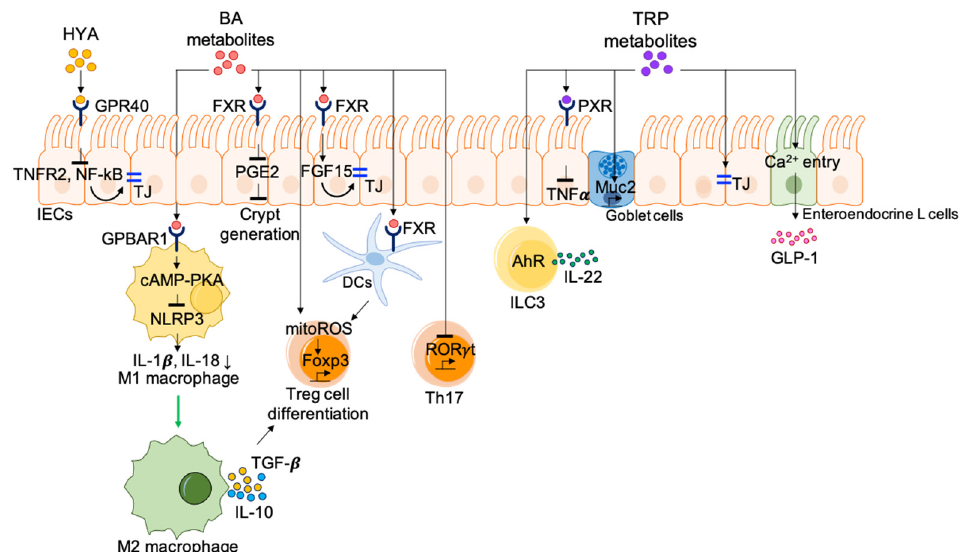
Figure 3. Immune regulation by metabolites derived from lipids and amino acids. Microbial metabolites produced from lipids and amino acids regulate intestinal homeostasis. HYAs from lipids and tryptophan metabolites induce the expression of TJ proteins on epithelial cells to fortify intestinal barrier integrity. Bile acid metabolites inhibit the differentiation of Th17 cells but promote Treg cell differentiation through the production of mitoROS and induce the conversion of M1 macrophages to M2 macrophages. Also, bile acid metabolites help to maintain gut barrier integrity through accelerating crypt regeneration. Tryptophan metabolites enhance intestinal homeostasis through AhR activation to promote IL-22 production in ILC3 and stimulation of enteroendocrine L cells to produce GLP-1. BA, bile acids; EFG15, epidermal growth factor 15; FoxP3, forkhead box P3; FXR, farnesoid X receptor; GLP-1, glucagon-like peptide-1; GPBAR1, G protein-coupled bile acid receptor 1; HYA, 10-hydroxy-cis-12-octadeccenoid acid; IECs, intestinal epithelial cells; mitoROS, mitochondrial reactive oxygen species; MUC2, mucin 2; PGE2, prostaglandin E2; PXR, pregnane X receptor; ROR γ t, RAR-related orphan receptor gamma; TJ, tight junction; TNF α , tumor necrosis factor alpha; TRP,